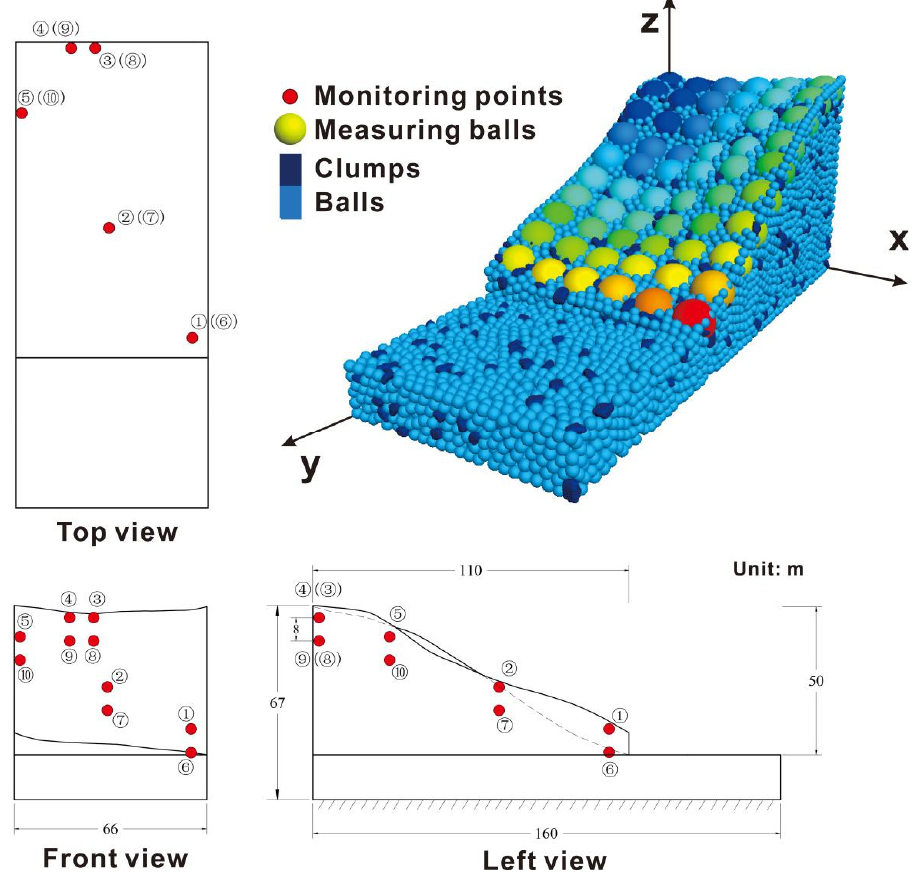
Figure 9. PFC3D coal-waste slope model and monitoring arrangement. (2) Fluid–solid coupling model.